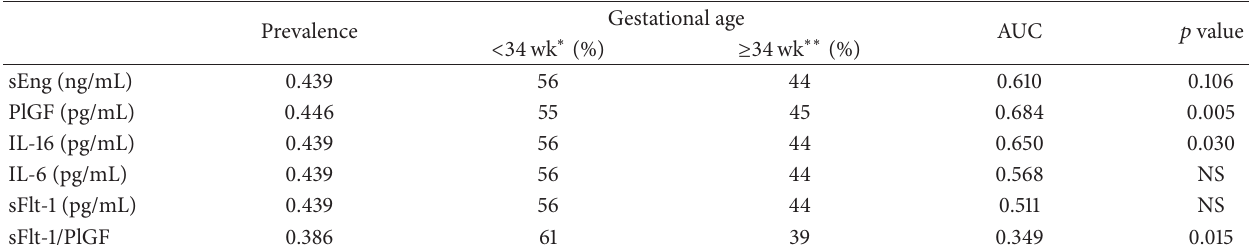
Table 3: AUC, 𝑝 value, odds ratio, and prevalence of sEng, PlGF, sFlt1, IL-6, and IL-16.